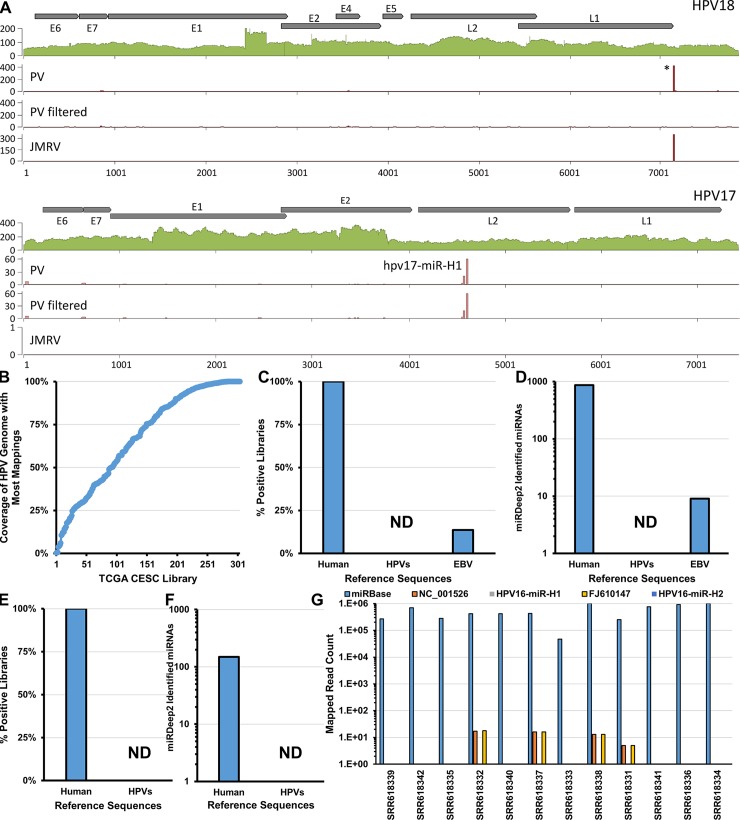
High Risk HPVs do not encode canonical microRNAs.(A) Coverage plots of miDGE DNA-seq and small RNA-seq across the genomes of HPV18 and HPV17. Filled green plots at the top of each panel show DNA-seq coverage, the three plots underneath show mapped small RNA-seq from: PV: HEK293T-cells transfected with our papillomavirus miDGE library, PV filtered: same reads as in PV, but filtered to eliminate low-complexity reads JMRV: Serving as a negative control, derived from 293T-cells transfected with our JMRV miDGE library. JMRV read counts were normalized to correct for different sequencing depths between PV and JMRV miDGE experiments (see total read counts in Table 1). Asterisk indicates a previously purported miRNA candidate region suggested in the literature [39], which is nonspecific (detected in the negative control JMRV miDGE analysis, lower plot) and can be eliminated by removing low complexity reads (center plot). (B) RNA-seq coverage for the most abundantly mapped HPV in 303 tumors in the TCGA CESC project [50]. Each of the 303 libraries are represented on the X-axis (sorted based on Y-axis value). Y-axis indicates the percentage of the positions in the HPV genome with read mappings. Libraries with > = 50% coverage (213 libraries) were used for subsequent analysis. (C) Percentages of TCGA cervical squamous cell carcinoma (CESC) libraries with miRDeep2 miRNA identifications for each set of reference sequences. Number of libraries examined is 213. (D) Number of unique miRDeep2 miRNA identifications across TCGA CESC libraries for each set of reference sequences. Number of libraries examined is 213. (E) Percentages of Qian et al. [40] libraries with miRDeep2 miRNA identifications for each set of reference sequences. Number of libraries examined is 12. (F) Number of unique miRDeep2 miRNA identifications across Qian et al. libraries for each set of reference sequences. Number of libraries examined is 12. (G) Raw read counts of all small RNAs mapping to the indicated reference sequences for each library from Qian et al.